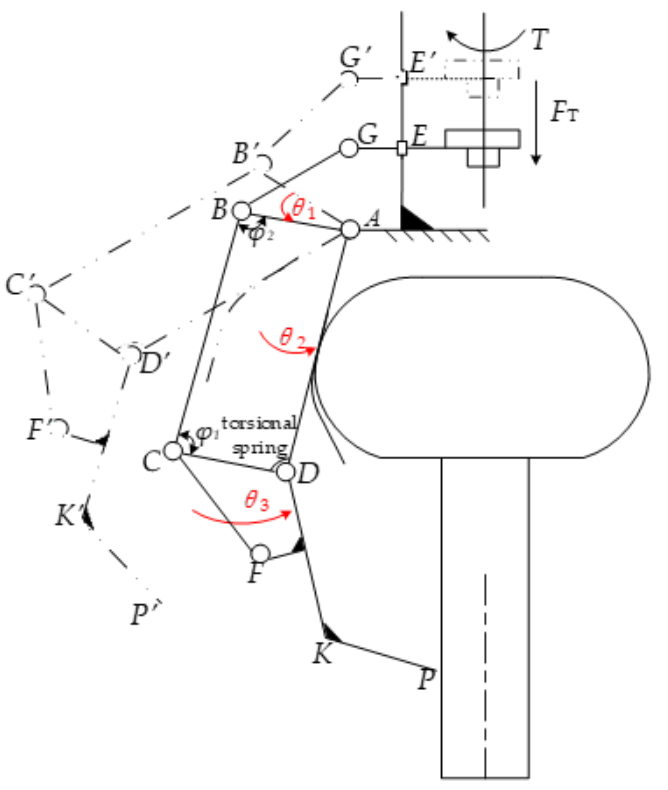
Figure 8. Motion analysis of the underactuated mechanism. Table 1. Symbol declaration of underactuated mechanism.